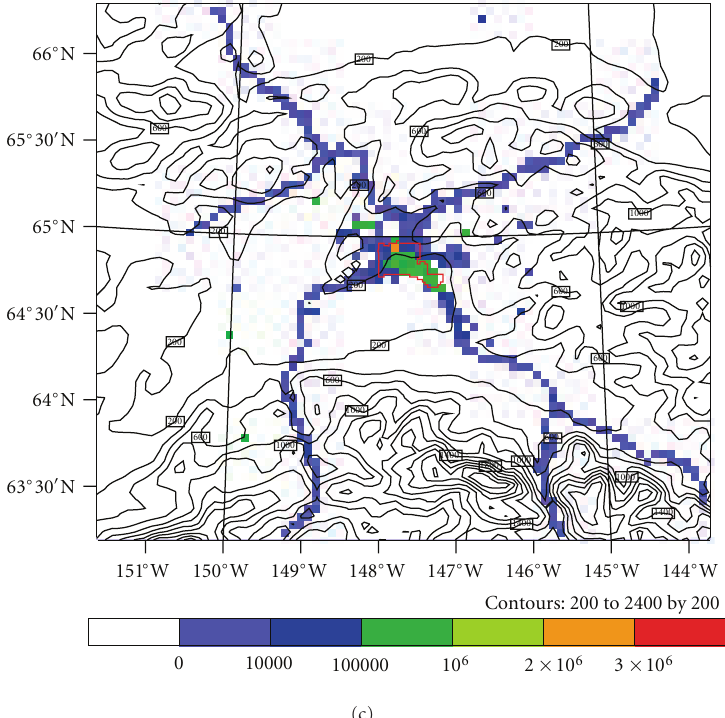
Figure 1: Total emission of (a) PM 2 . 5 , (b) SO 2 , and (c) NO x from October 1, 2008 to March 31, 2008 (color) from all layers in the analysis domain. Terrain height is superimposed (contour lines). In (a), the red polygon and black circular shape indicate the boundaries of the Fairbanks nonattainment area and the location of the o ffi cial PM 2 . 5 -monitoring site,